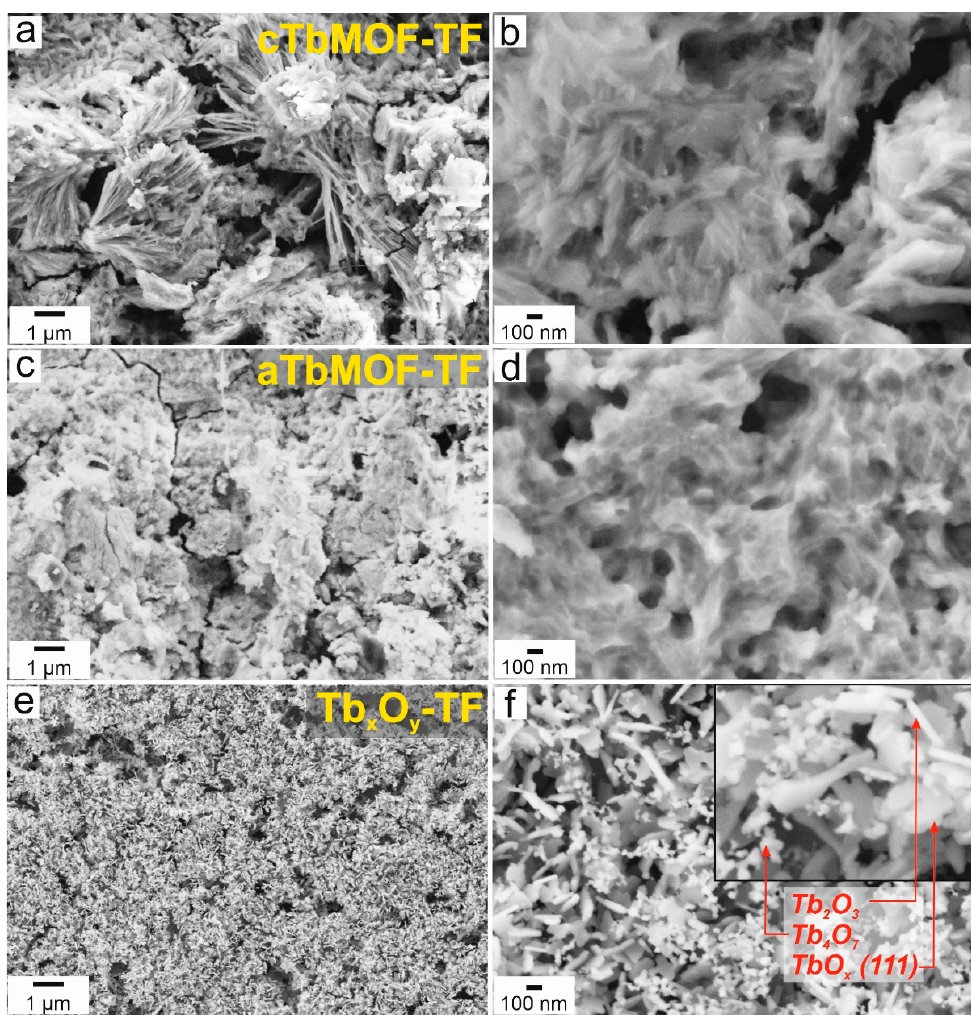
Figure 8. SEM surface microstructures of ( a , b ) crystalline cTbMOF-TF, ( c , d ) amorphous aTbMOF-TF, and ( e , f ) Tb x O y -TF thin films on Pt/SiO 2 /Si substrates (in the inset, three types of particles are visible: flower-like TbO x (111), rod-like Tb 2 O 3 ,and flake-likeTb 4 O 7 ).